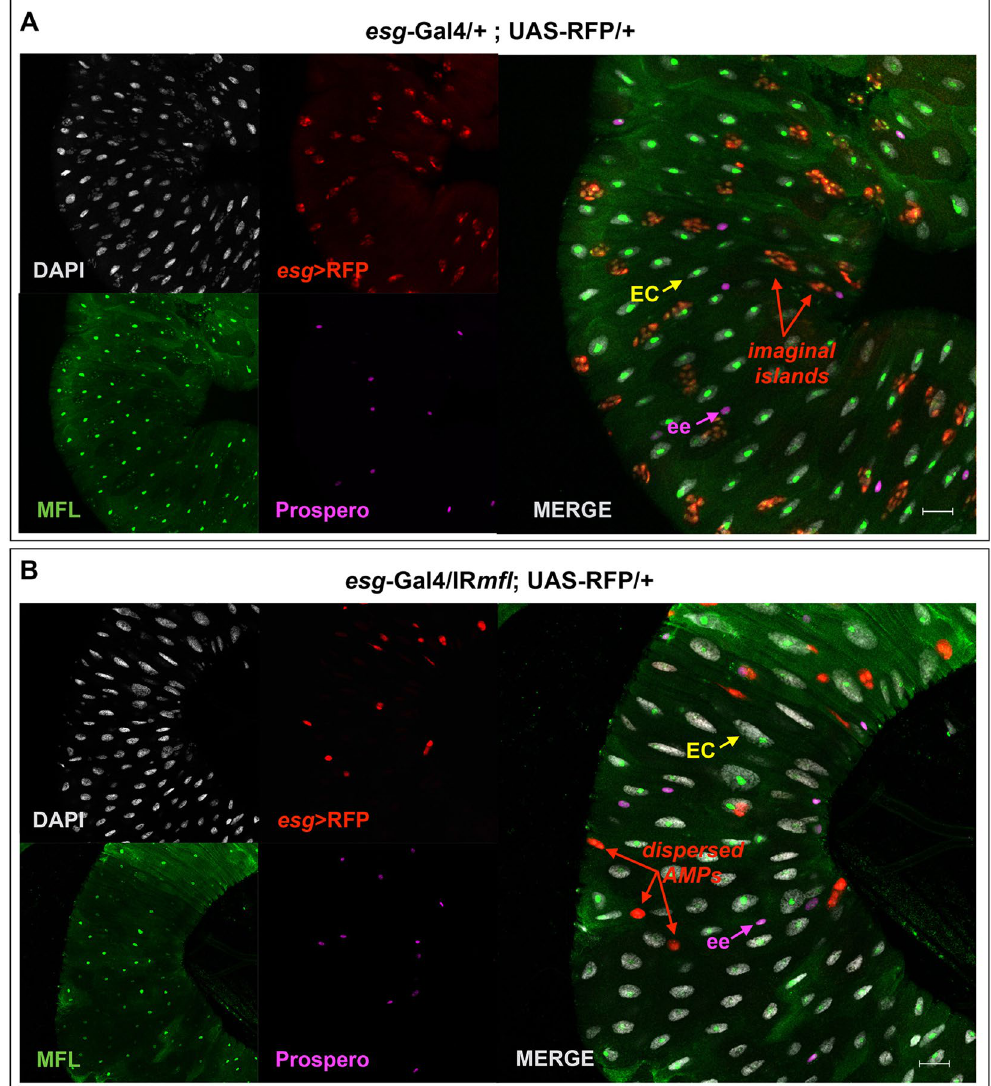
Figure 4. Dyskerin depletion strongly reduces the number of midgut stem cell progenitors. Confocal microscope images of control ( A ) and silenced midgut ( B ) at the third larval stage. DAPI is in gray; esg - expression domain is marked in red by the UAS-RFP responder line; staining with anti-MFL is in green; anti- Prospero, which specifically marks ees cells, is in purple. Scale bars: 20 µ m. In both ( A and B ), purple arrows indicate an ee cell, yellow arrows an enterocyte EC. Red arrows indicate imaginal islands in ( A ), and dispersed esg + pros - cells (AMPs and PCs) in ( B